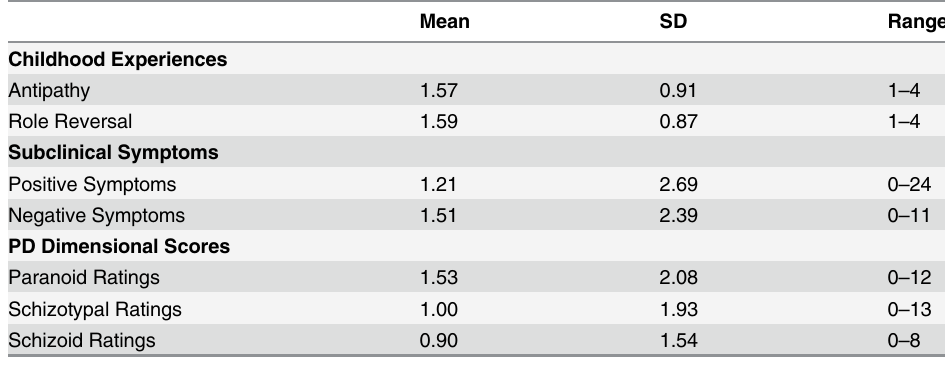
Table 1. Descriptive Data for Antipathy, Role Reversal, and Schizophrenia-Spectrum Phenomenology. Mean SD